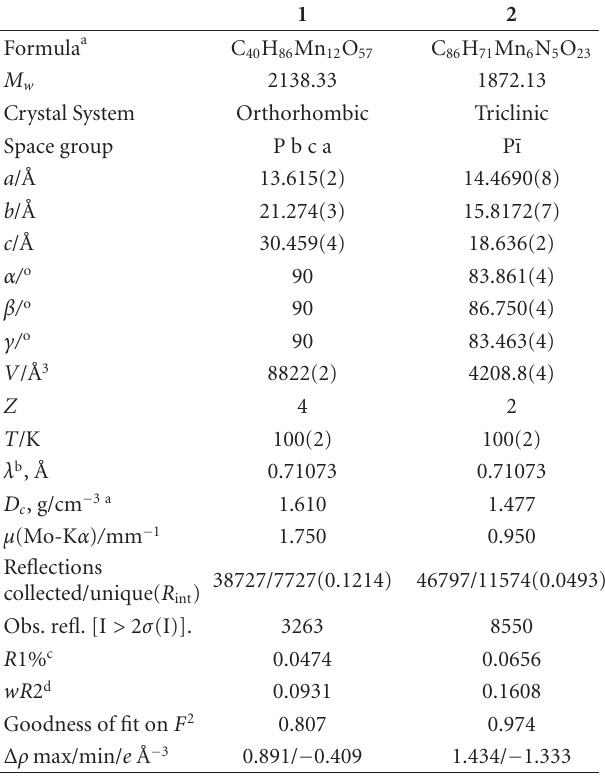
Table 1: Crystallographic data for complexes ( 1 · 2.5H 2 O) ∞ and ( 2 ·